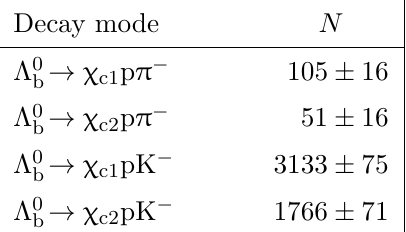
Figure 2 . Mass distribution for selected Λ 0 is overlaid.